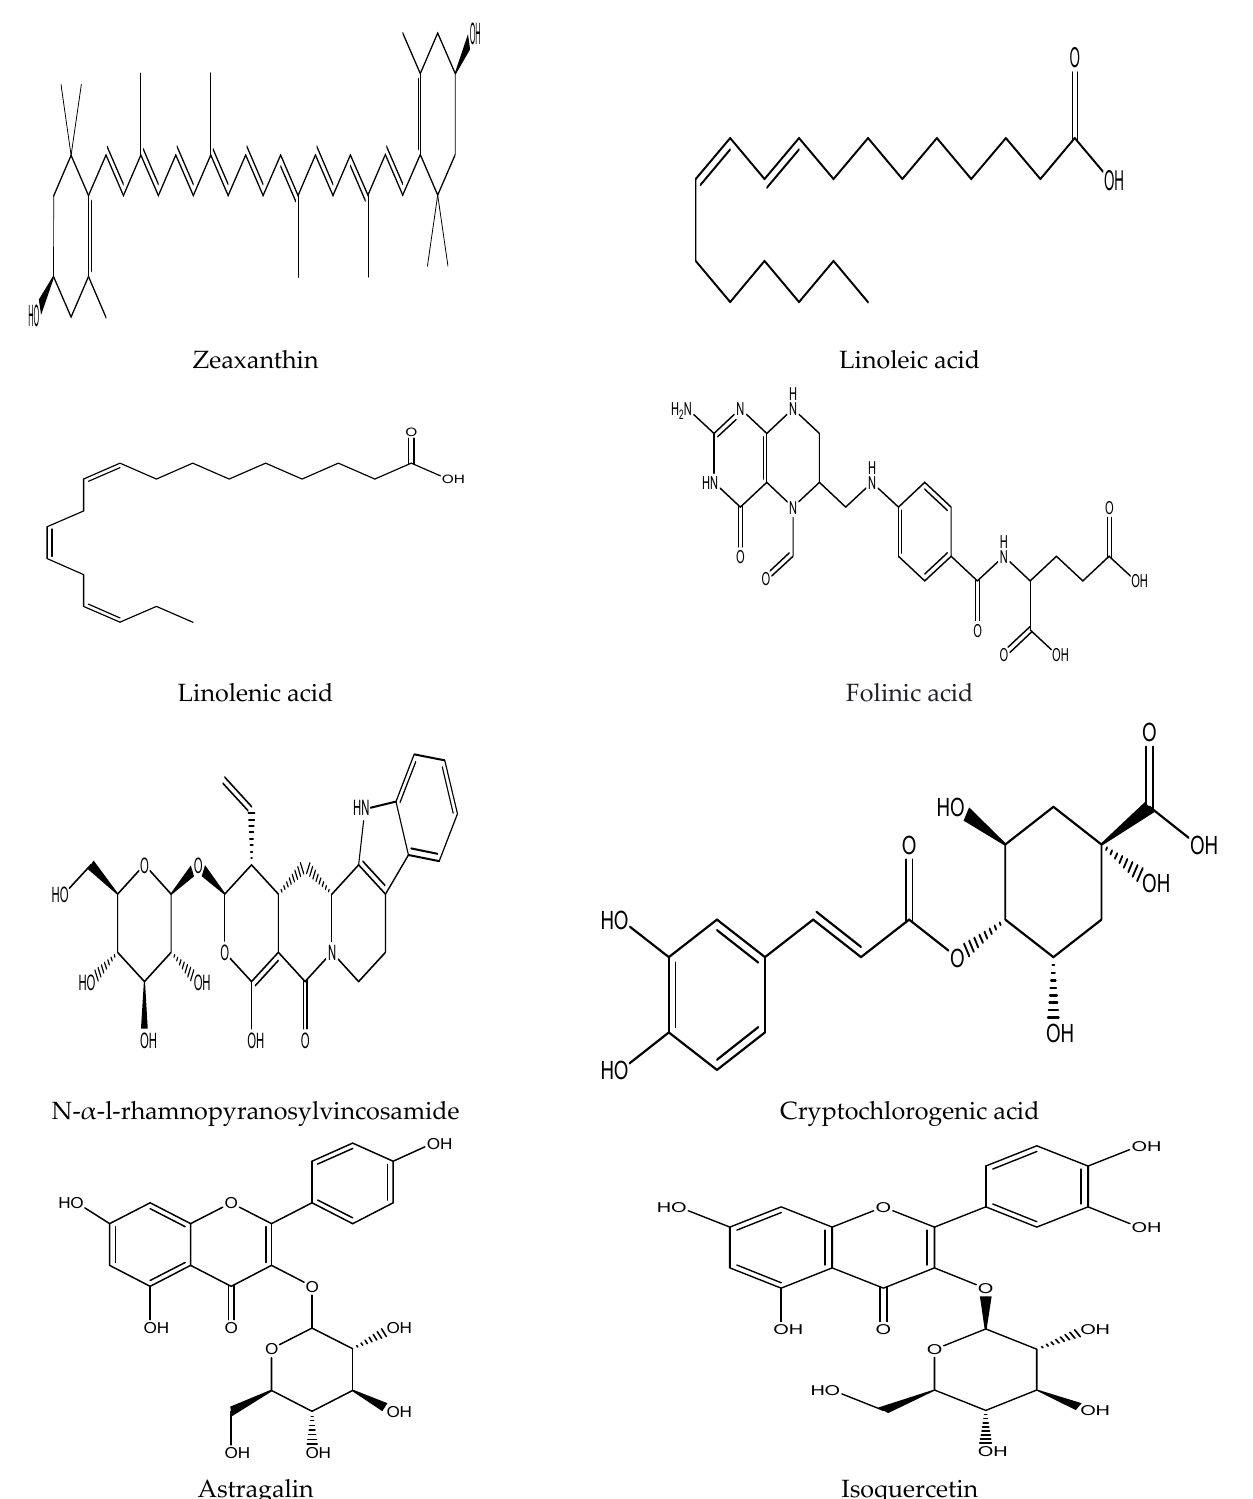
Figure 1. Chemical structure of some bioactive compounds presents in Moringa oleifera leaves.